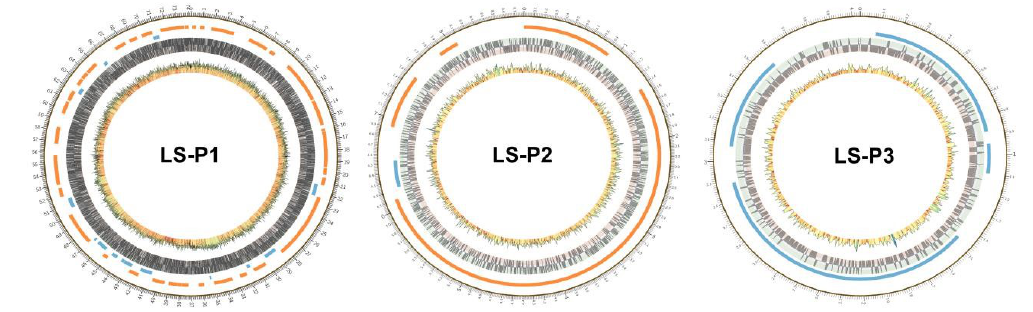
Figure 8. The genome circular maps of L. sakei plasmids.